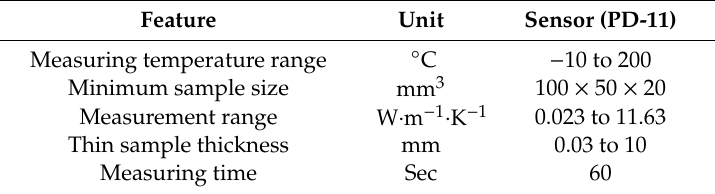
Figure 5. QTM-500 complete measurement setup. Table 2. Specification of PD-11 prob.